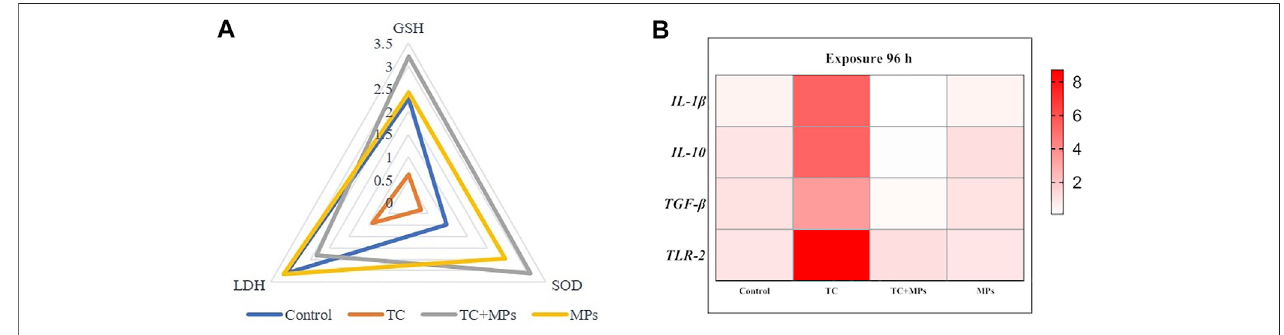
the above genes in Jian carp after exposure of 96 h are shown in Figure 4 . The relative expression levels of all detected genes only in TC exposure group were signi fi cantly upregulated ( p < 0.01), were not.